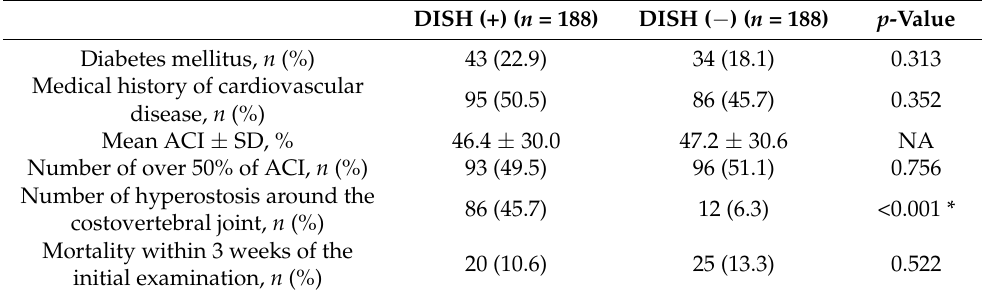
Table 3. Medical history, ACI, costovertebral joint fusion and